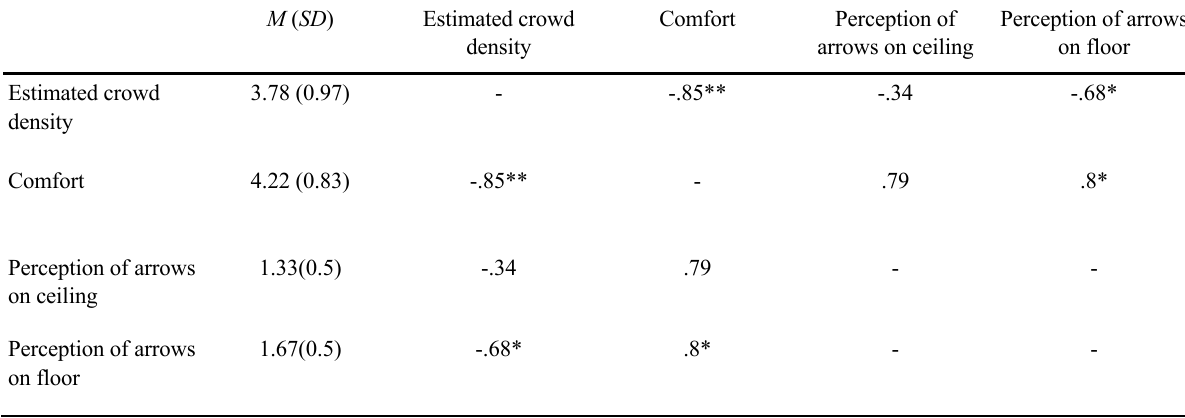
Table 2. Summary of Correlations, Means and Standard Deviations for estimated crowd density, comfort, and number of gazes at arrows on the ceiling and floor,